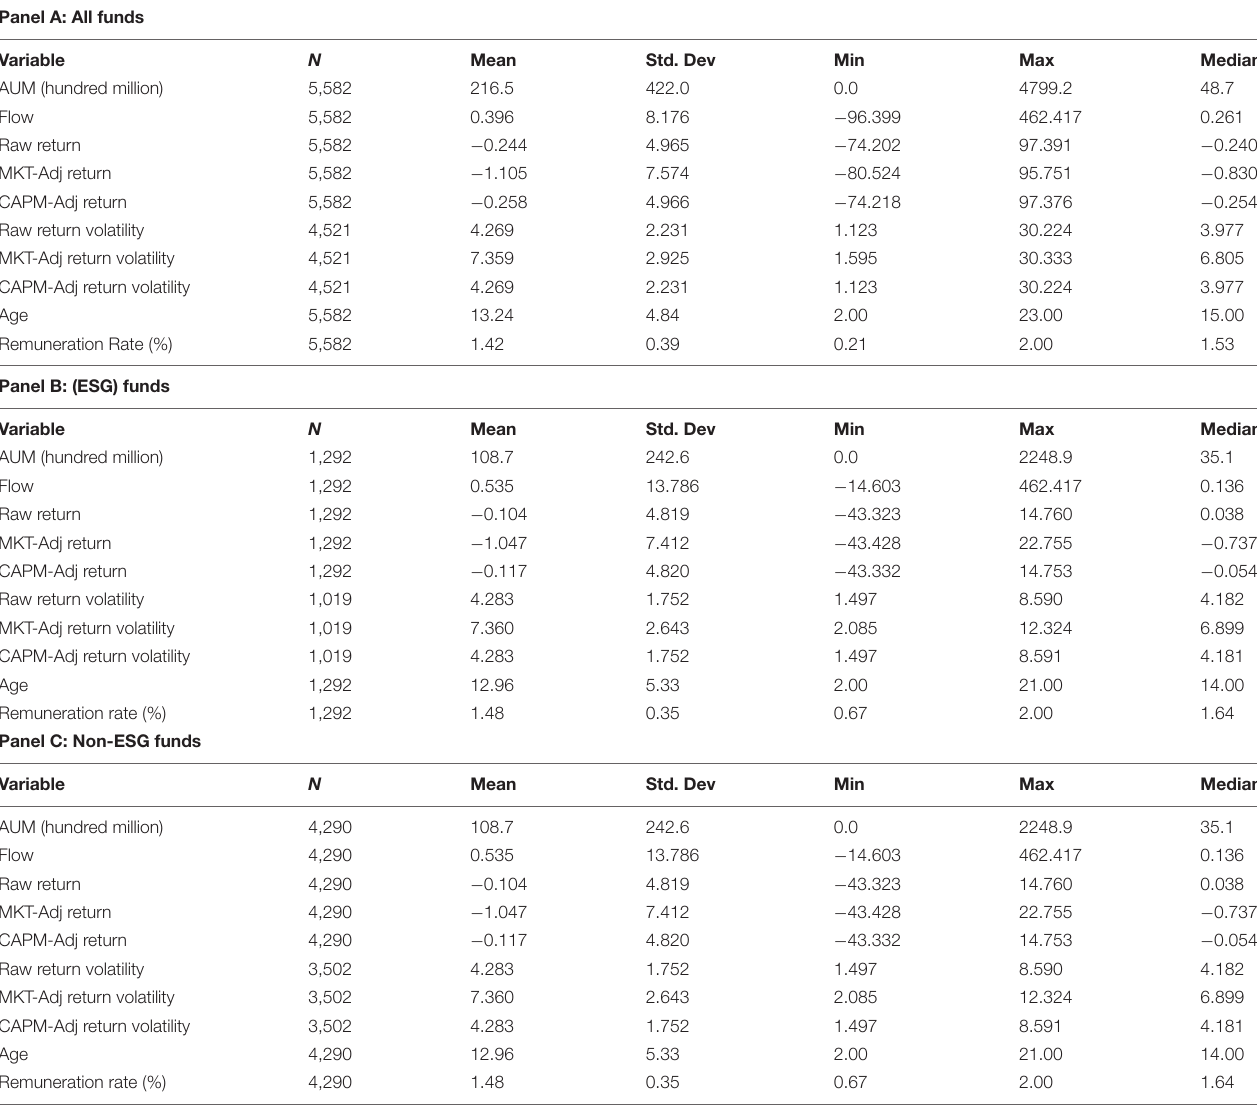
TABLE 1 | Descriptive statistics on reference data